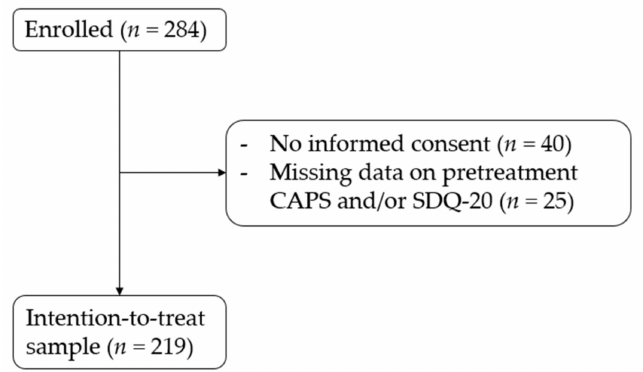
Figure 1. Flowchart for the intention-to-treat sample used for main